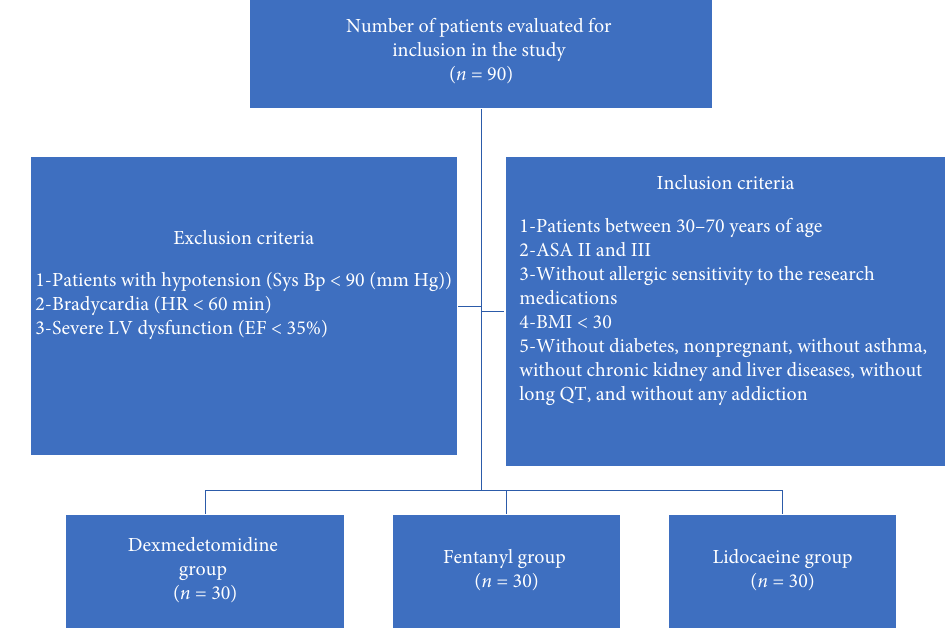
Figure 1: Consort